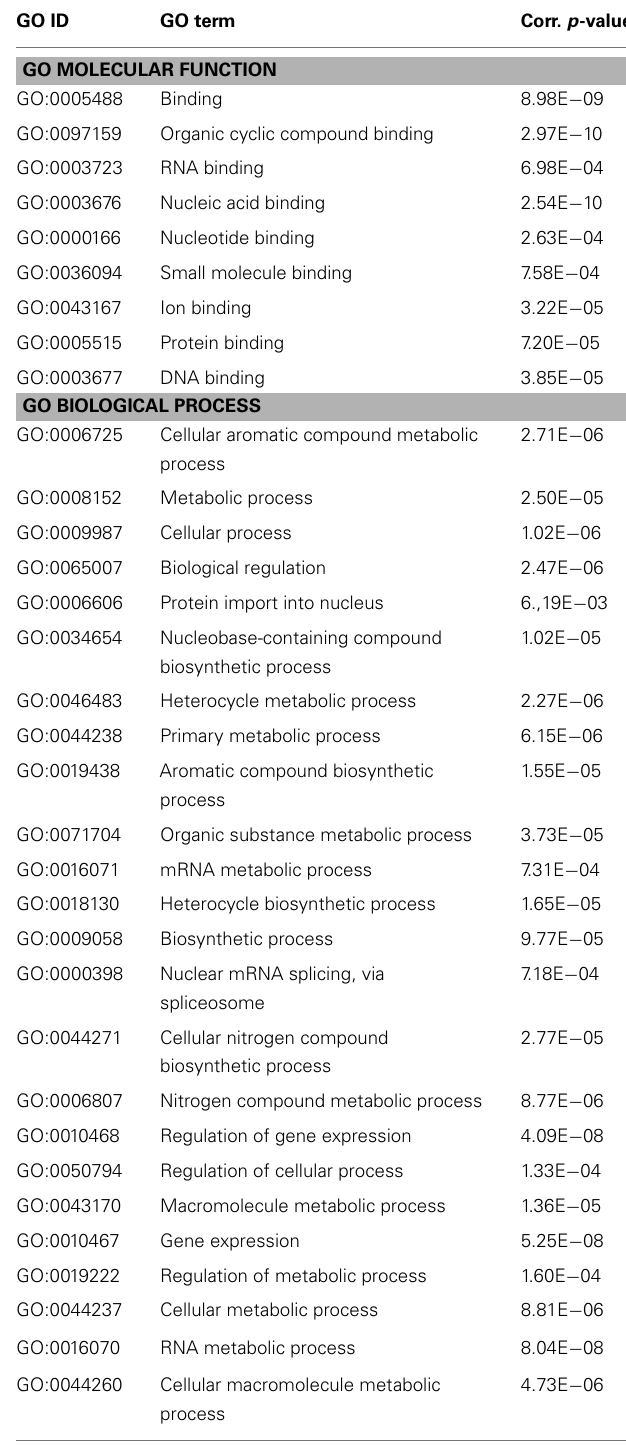
Indicated are gene ontology IDs (GO ID), gene ontology terms (GO term), and corrected p-values as determined by GenericGeneOntologyTermFinder (http: //go.princeton.edu/cgi-bin/GOTermFinder) and REViGO